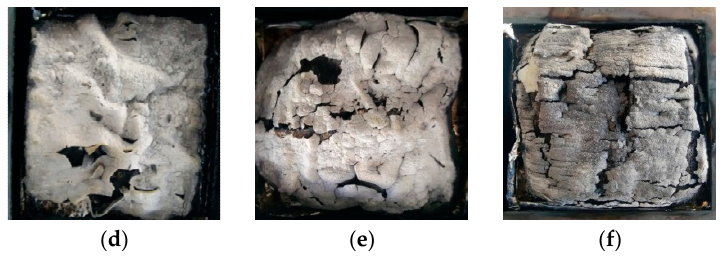
Figure 3. Appearance of specimens after combustion including ( a ) S0, ( b ) S1, ( c ) S2, ( d ) S3, ( e ) S4, ( f ) S5.